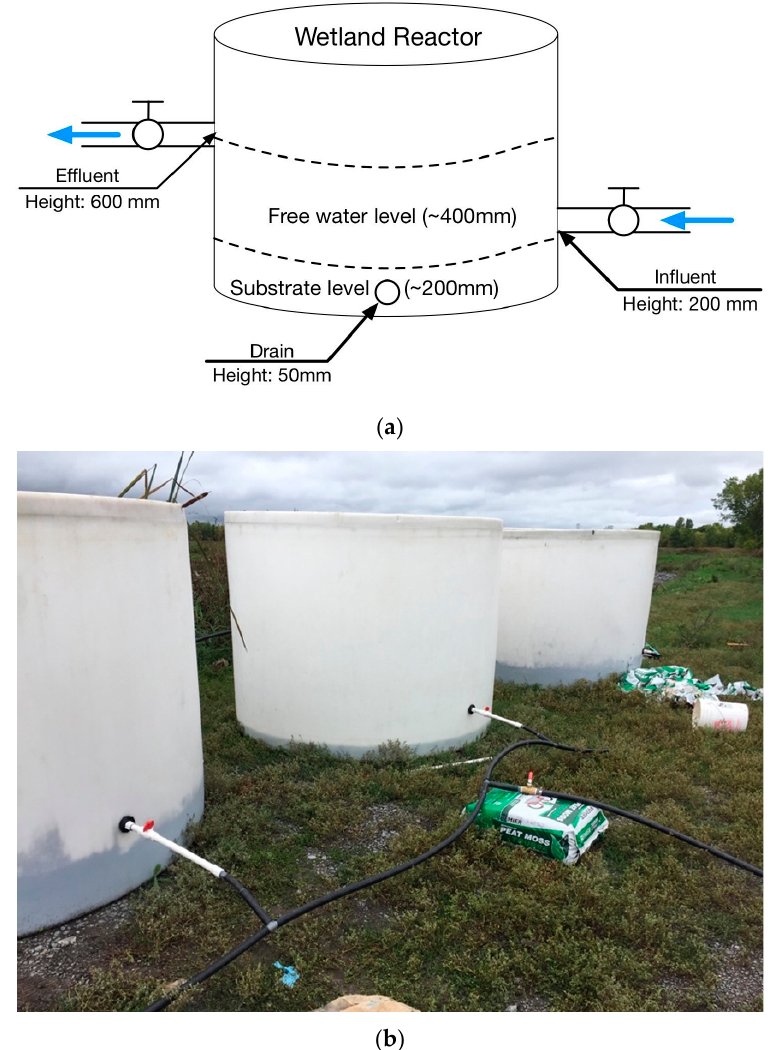
Figure 2. ( a ) Detail design and dimensions of the individual treatment wetland reactors (not to scale); and ( b ) three constructed wetland reactors with connection tubing and flow control valves in the field.